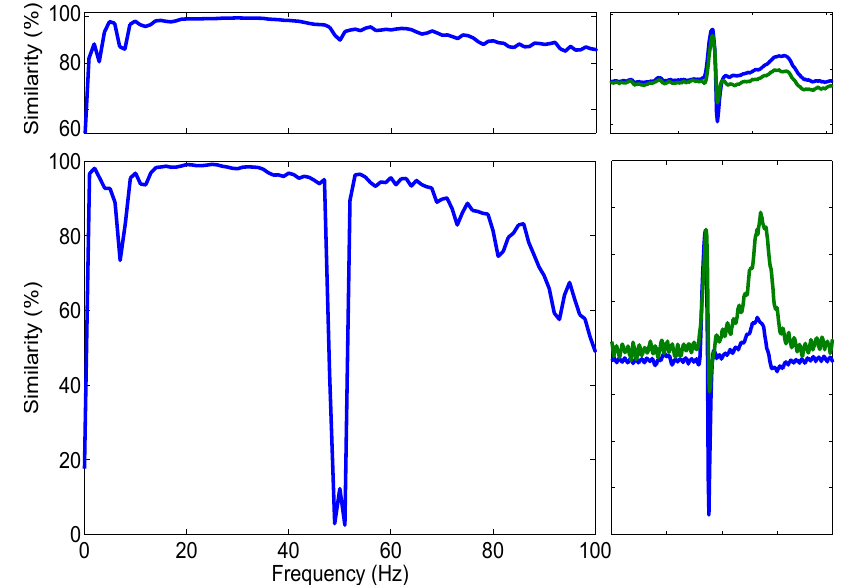
Figure 7. Left shows similarity plots of the capacitive electrode data, Bootstrapped electrode ( top ); and current-to-voltage converter ( bottom ). Right shows raw 1 s excerpts of the bio-potential recordings (blue Ag/Cl, green capacitive electrode).